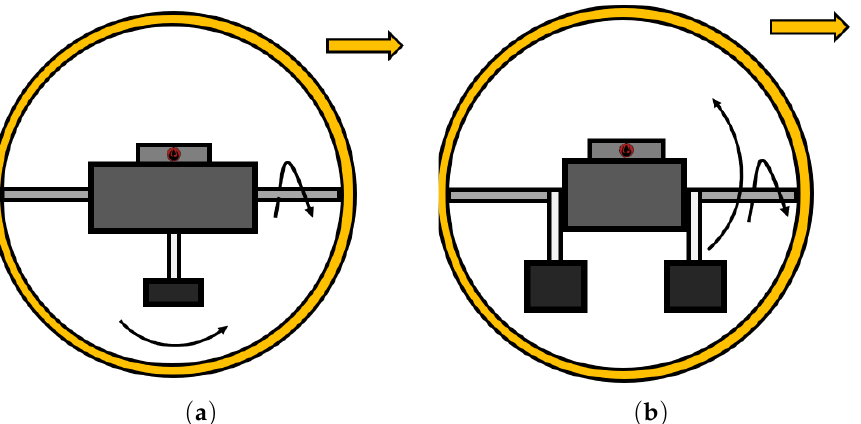
Figure 4. Principle sketches of a pendulum mechanism. ( a ) Single pendulum mechanism. ( b ) Double pendulum